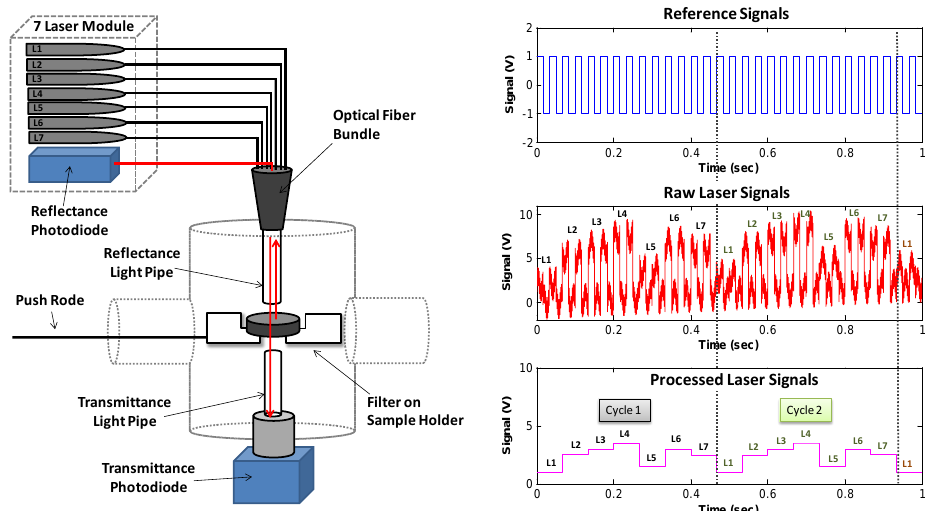
Figure 1. Configuration of optical sensing (left) modified from the DRI Model 2001 analyzer (Chen et al., 2012). The seven-laser module (i.e., L1-L7) represents seven diode lasers with wavelengths of 405, 450, 532, 635, 780, 808, and 980nm. Reference (top right) and laser (middle right) signals are modulated at 30Hz for a lock-in amplification of the reflectance or transmittance signals (bottom right). Only 30Hz signals with the same phase as the reference are amplified at gains proportional to the reference signal voltage and number of data points